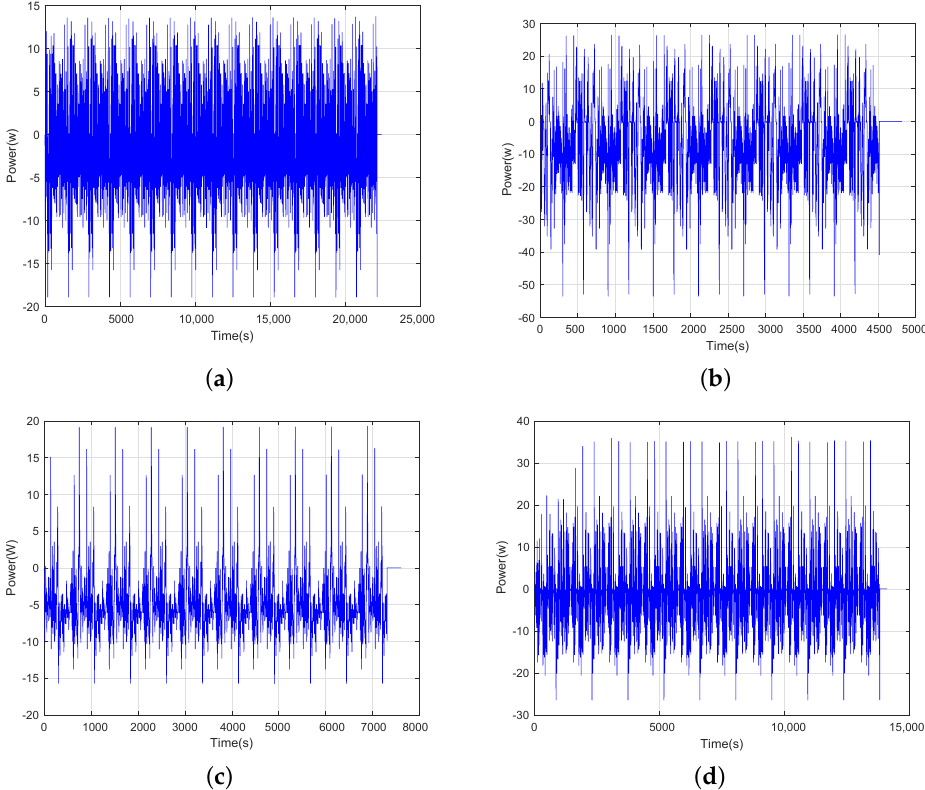
Figure 5. The drive cycle powers used for the training and testing phases at 25 ◦ C for a one cell of battery pack of Ford F150 for: ( a ) UDDS; ( b ) US06; ( c ) HWFT; and ( d ) LA92 profiles. The A123 battery is a lithium iron phosphate battery ( LiFePO 4 battery). LiFePO 4 batteries are a type of li-ion batteries being used in EVs and Electric bikes. Table 2 represents the specification of A123 battery. Table 2. The specification of the A123 battery parameters.